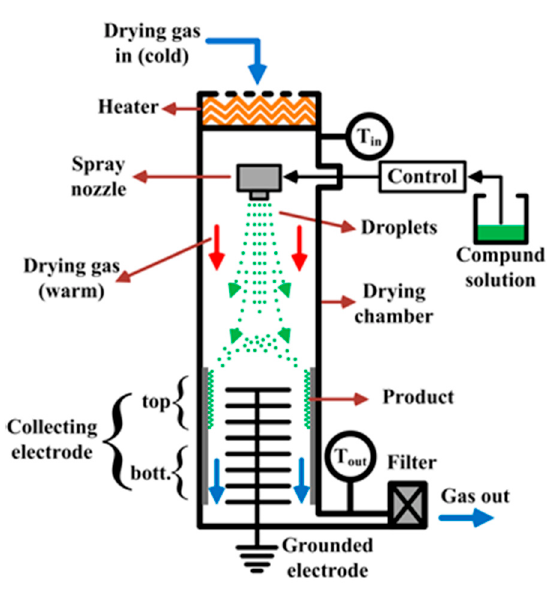
Figure 4. Schematic representation of a nano spray dryer. Buchi Labortechnik AG, [28].